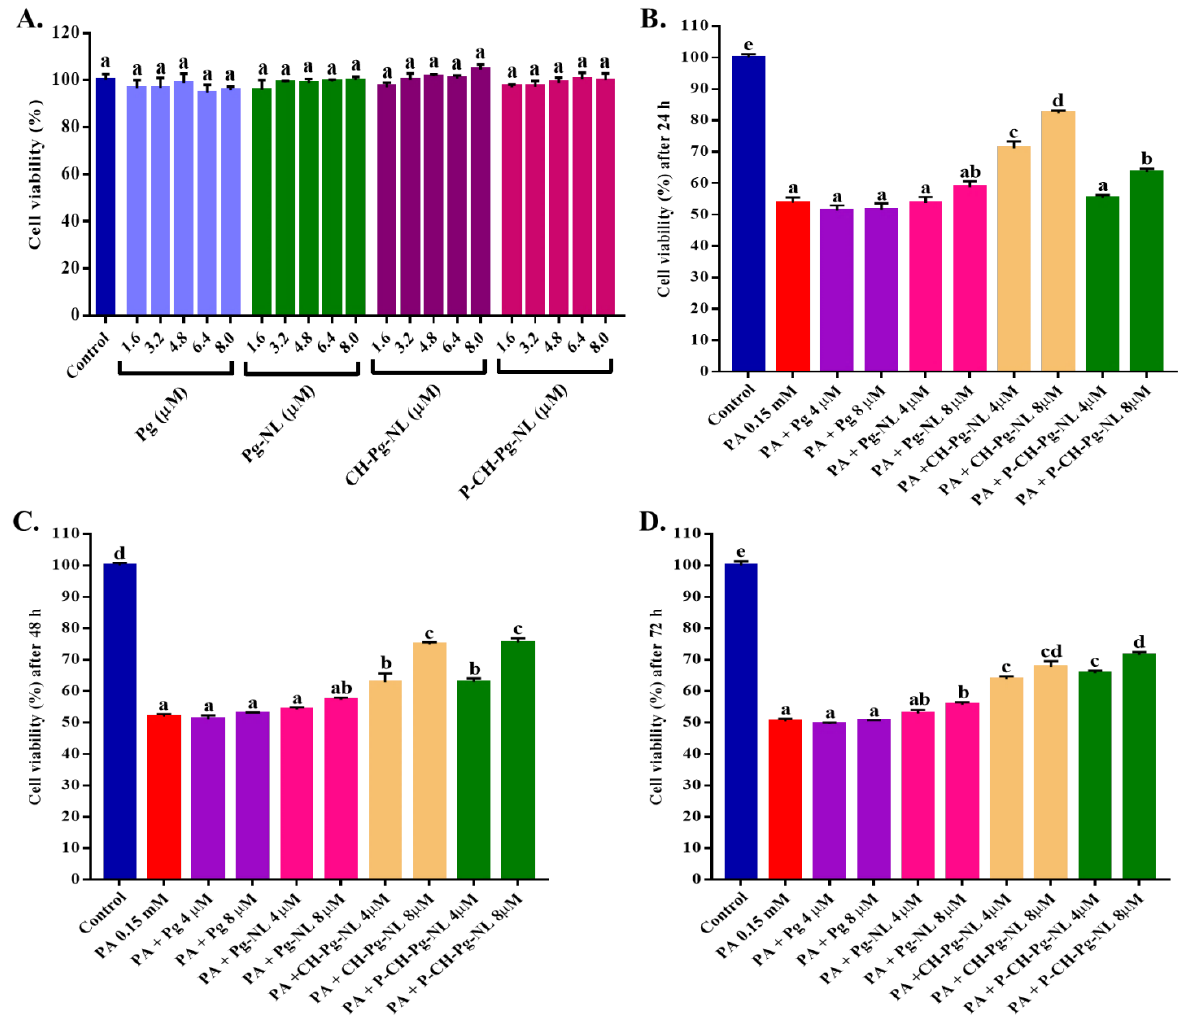
Figure 2. Effects of free-Pg and Pg-loaded liposomal systems on cytotoxicity and PA-induced lipotoxicity in L02 cells. ( A ) Cells were treated for 24 h with 1.6–8.0 µ M of free-Pg and Pg-loaded nanoliposomes, and cell viability was evaluated by MTT assay (% of control). ( B – D ) Cells were treated for 24 h with 0.15 mM PA with or without free-Pg and Pg-loaded nanoliposomes for 24, 48, and 72 h, accordingly. After that, cell viability was evaluated by MTT assay (% of control). Individual alphabet represents the significant difference ( p < 0.05) of all treatment groups. Here, PA = palmitic acid; Pg-NL = Pelargonidin- 3-O -glucoside-loaded uncoated nanoliposomes; CH-Pg-NL = Pg-NL coated by chitosan; P-CH-Pg-NL = CH-Pg-NL coated by